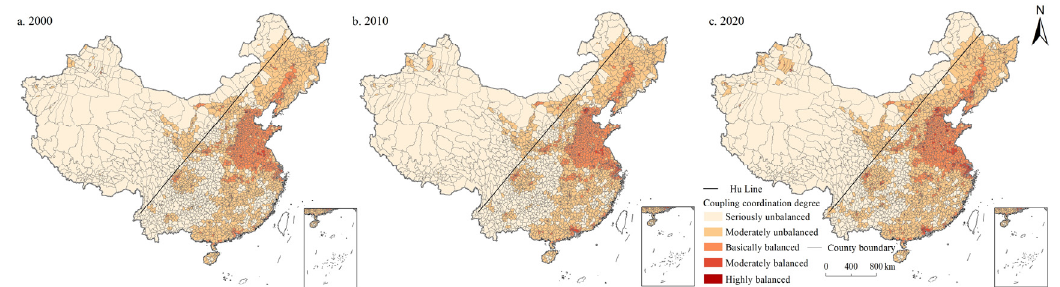
Figure 5. Spatial distribution of coordination degree of PSI and LSI in China during 2000–2020.